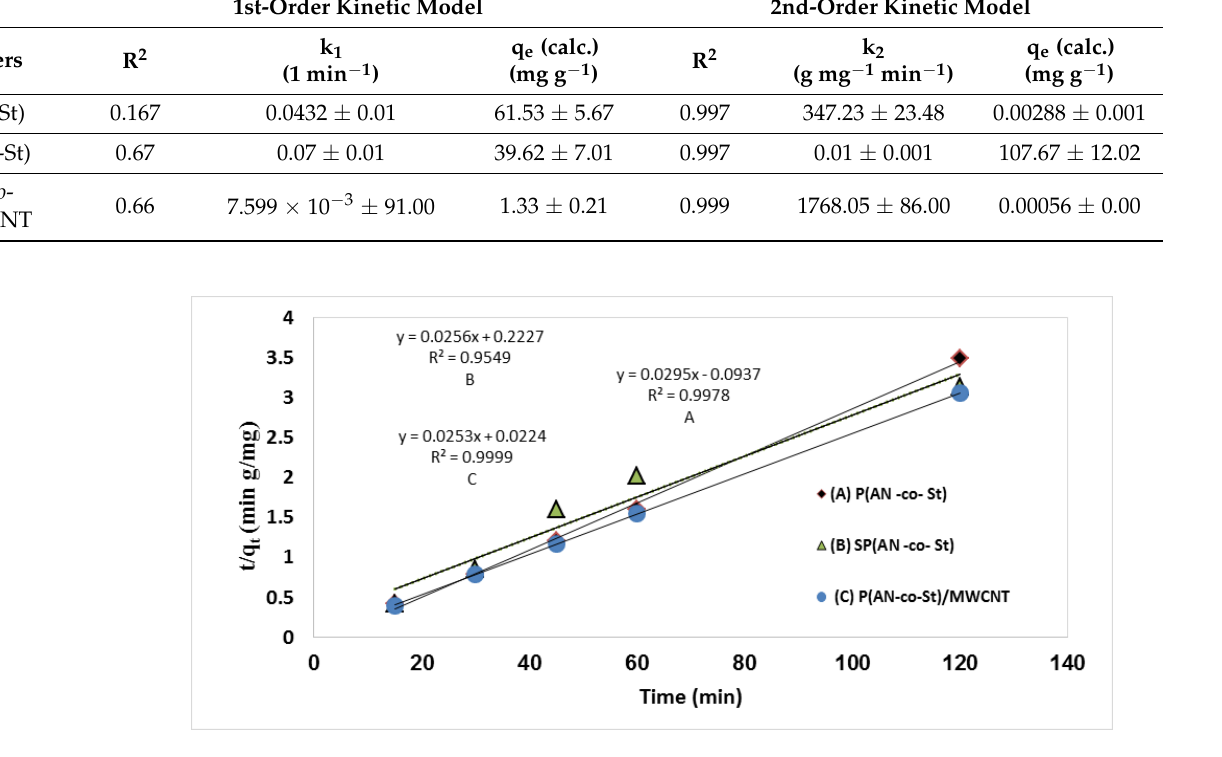
Figure 15. Second-order kinetics for the removal of MO onto various